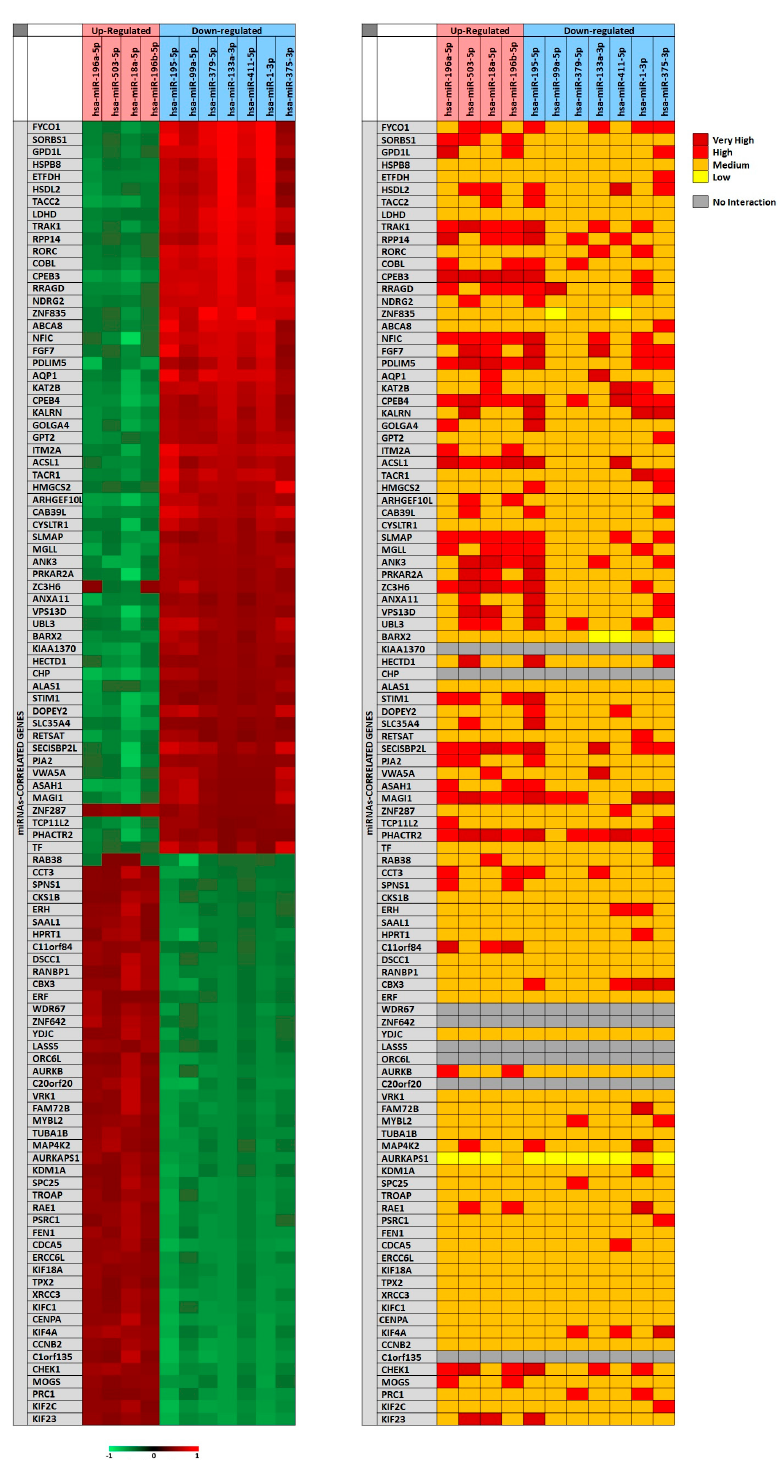
Figure 2. Panel ( A ) miRCancerdb analysis of genes whose expression is positively and negatively related to the 11 selected miRNAs; panel ( B ) mirDIP analysis of interaction levels between miRNAs and related genes.